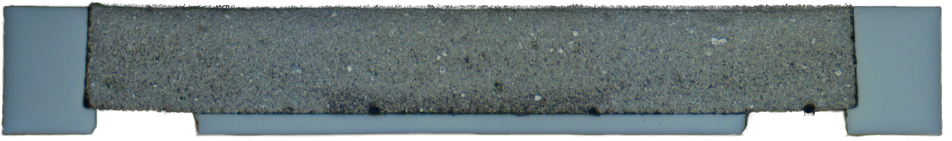
Figure 3. SEM micrograph of a cross-sectional polish through a silicon chip as shown in Figure 2.